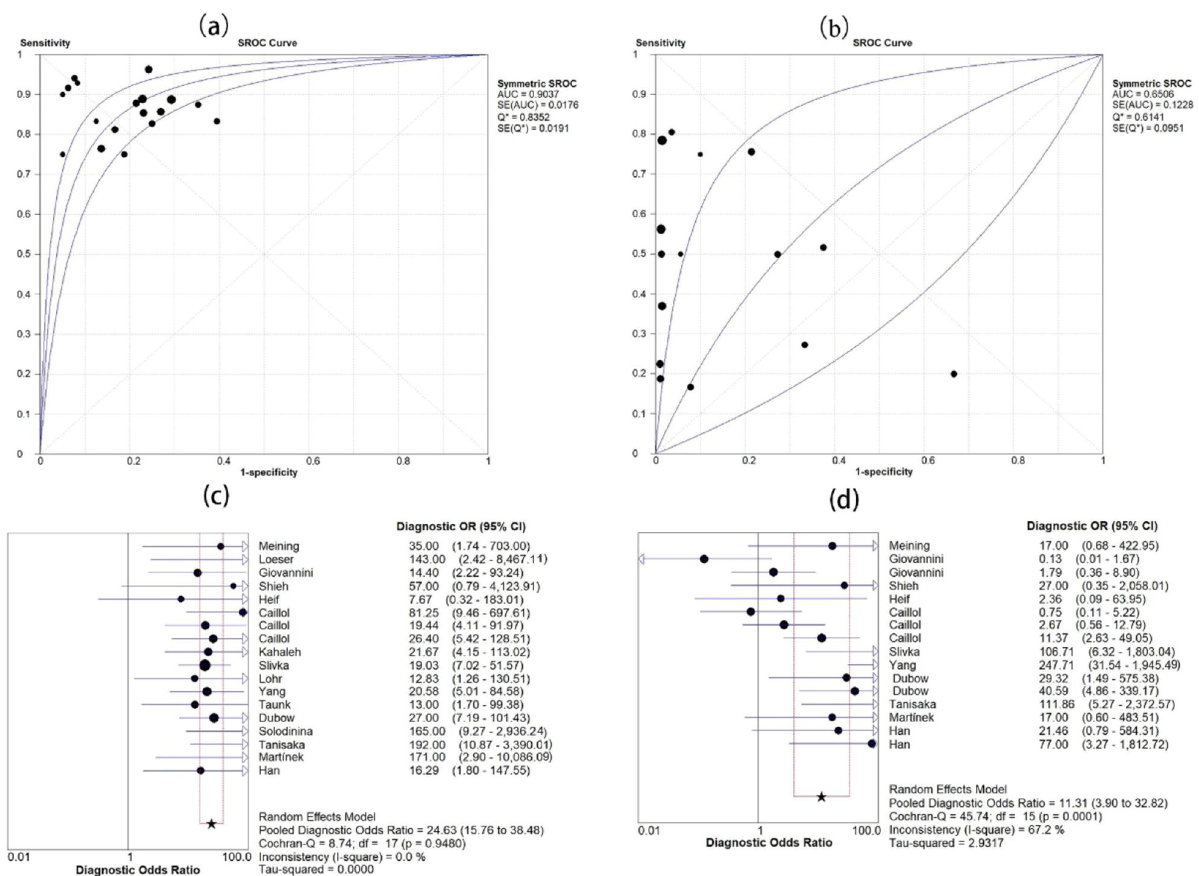
Figure 5. SROC plot and DOR of pCLE ( a , c ) and tissue sampling by ERCP ( b , d ) in diagnosing indeterminate biliary